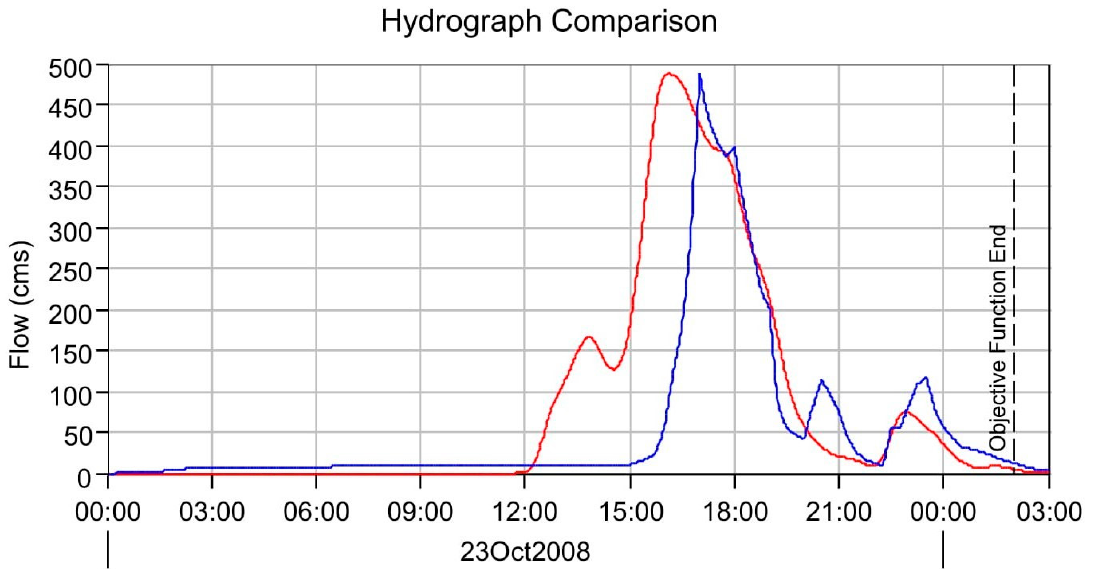
Figure 6. The observed and simulated hydrograph after calibration.